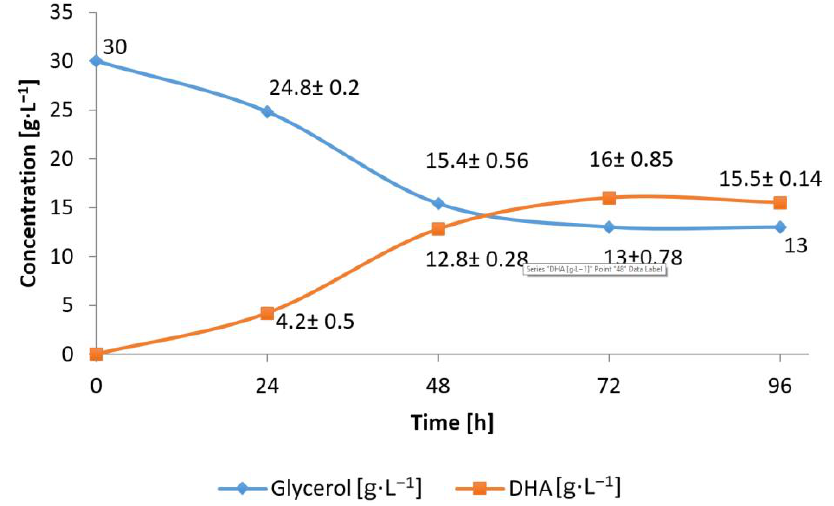
Figure 6. Time profiles of glycerol conversion and DHA formation during bioconversion of 30 g · L − 1 of a waste glycerol fraction with a free cell extract obtained from G. oxydans .